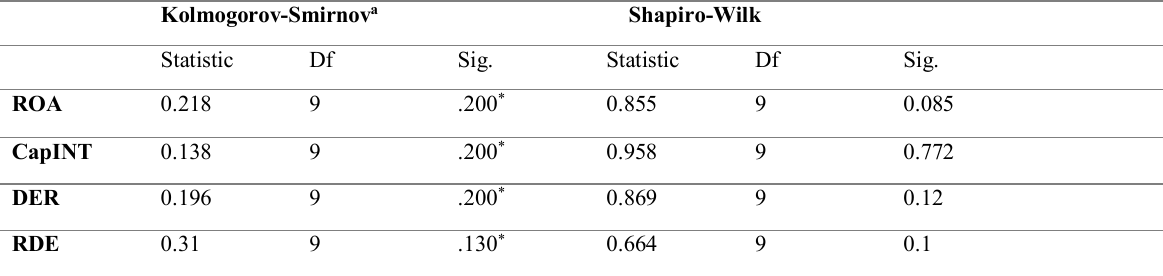
Table 2: Tests of Normality